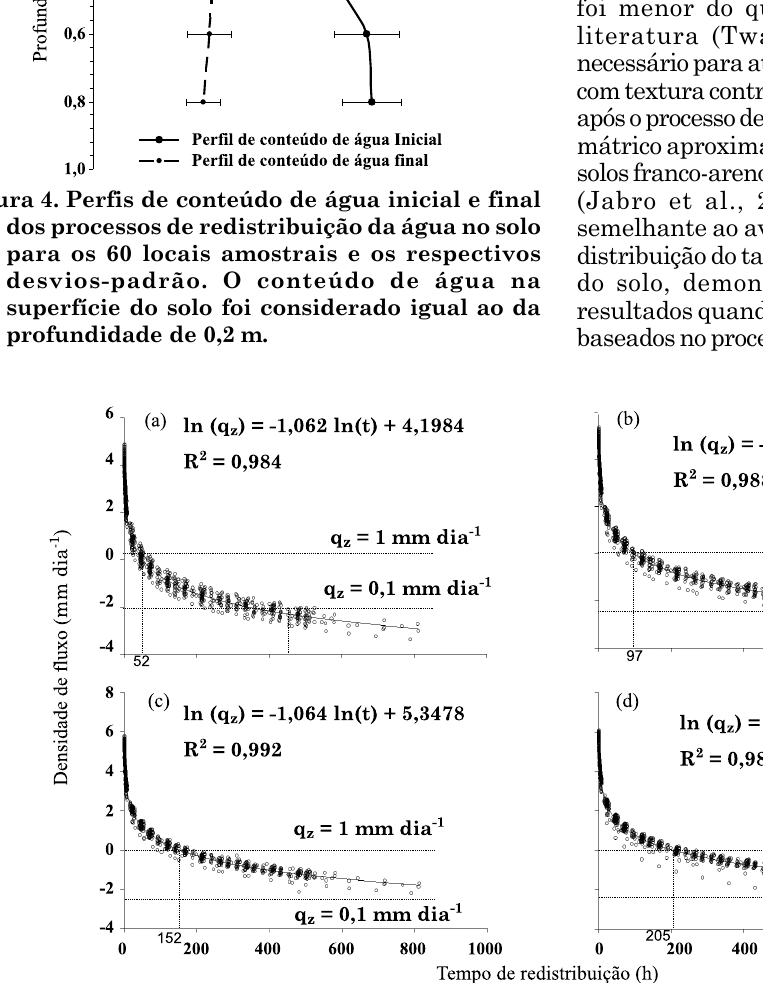
Figura 5. Densidade de fluxo da água (Ln q ) em função do tempo de redistribuição da água no solo, z determinada pela equação (2) nas profundidades (m) de 0,2 (a), 0,4 (b), 0,6 (c) e 0,8 (d), em 60 repetições e contendo 965